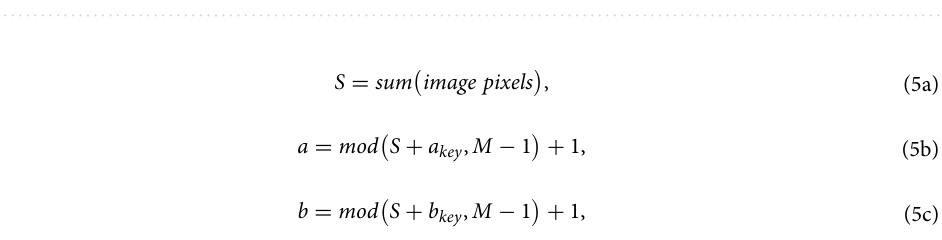
Figure 8. System key